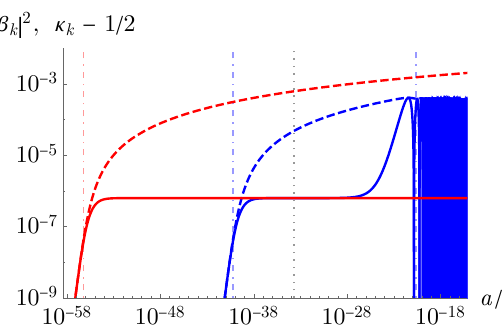
Figure 2 . Time evolution of the instantaneous photon number j (cid:12) k j 2 (dashed lines) and quantum- ness parameter (cid:20) k subtracted by 1 = 2 (solid lines), for wave numbers k=a 0 = (10 Gpc) (cid:0) 1 (red lines) and (10 (cid:0) 6 pc) (cid:0) 1 (blue lines). The beta function coe(cid:14)cient is set to b = 0 : 01. The background cos- mology is (cid:12)xed as H inf = 10 14 GeV where in(cid:13)ation ends at the vertical dotted line, and reheating with T reh = 100 GeV taking place at the right edge of the plot. The wave mode k=a 0 = (10 Gpc) (cid:0) 1 exits the Hubble horizon at the vertical red dot-dashed line, whereas k=a 0 = (10 (cid:0) 6 pc) (cid:0) 1 exits and then re-enters the horizon at the blue dot-dashed lines.